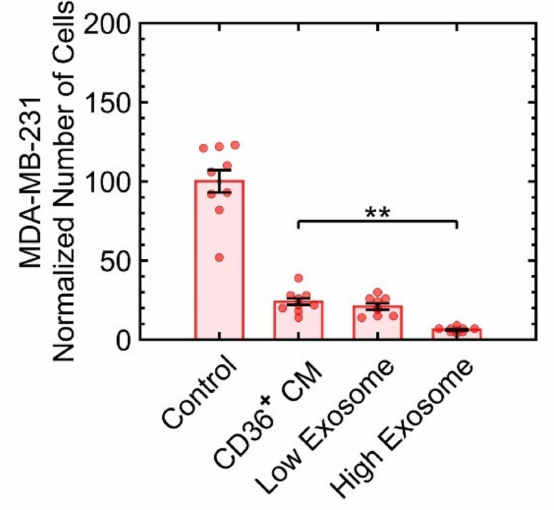
Figure 6. Induced high biogenesis of exosomes marginally increases growth suppression. At low exosome production, there was no statistical significance in growth suppression compared to the treatment with the CM of CD36 + FB. ** p < 0.001.